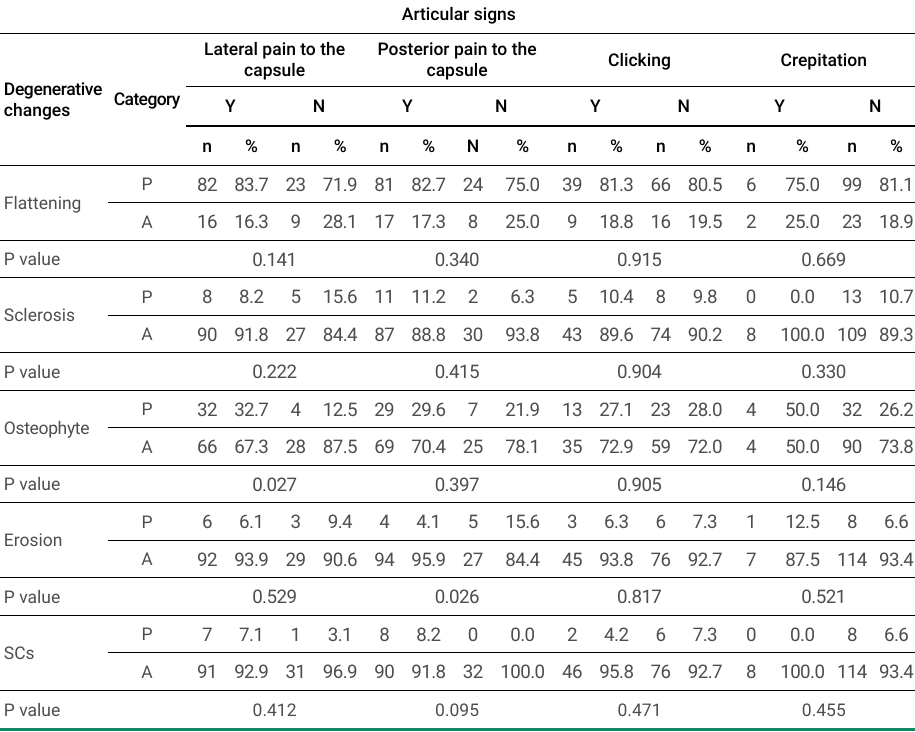
Table 3. Cross tabulation of the occurrence of degenerative changes and articular signs and the significance of the chi-square test. Articular signs